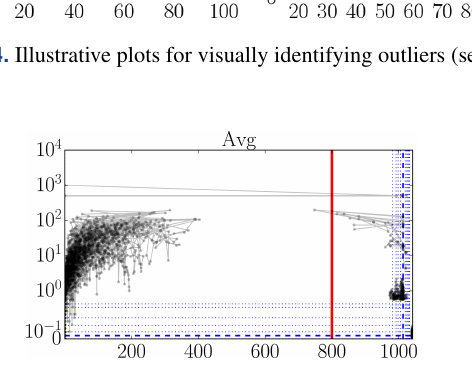
Figure 5. Illustrative plots for visually identifying outliers (see text for an explanation): FINO1 21m air pressure data (hPa).